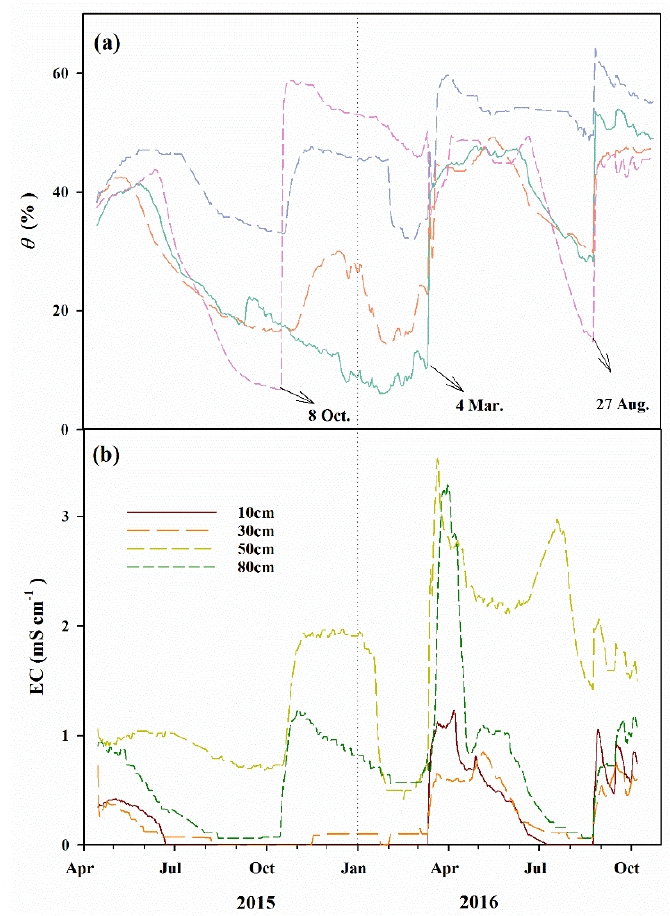
Figure 4. Seasonal variations of the daily: ( a ) soil moisture content ( θ , %), and ( b ) electrical conductivity (EC, mS cm − 1 ) for P. euphratica stand for the period 2015–2016.